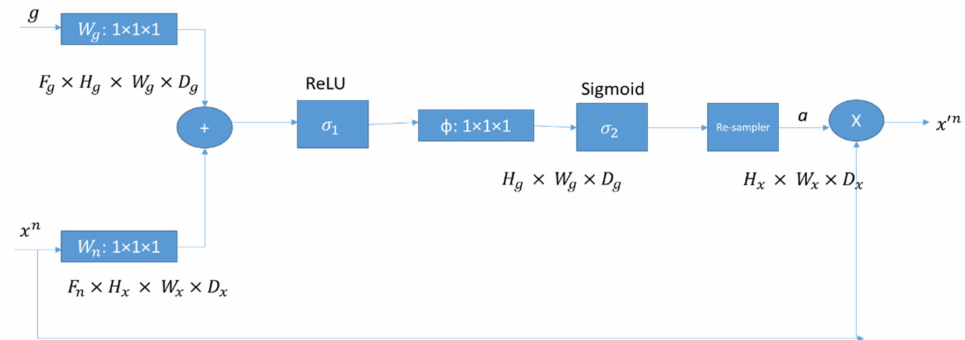
Figure 8. Selection